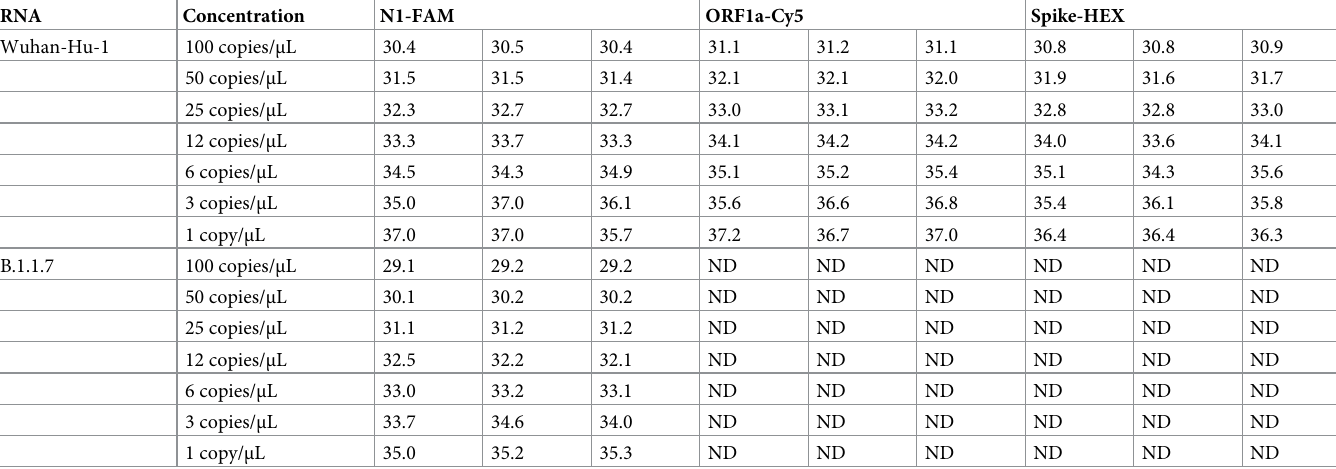
Listed are Ct values for the 3 primer–probe sets targeting the SARS-CoV-2 nucleocapsid (N1-FAM), ORF1a 3675–3766 deletion (ORF1a-Cy5), and spike 69–70